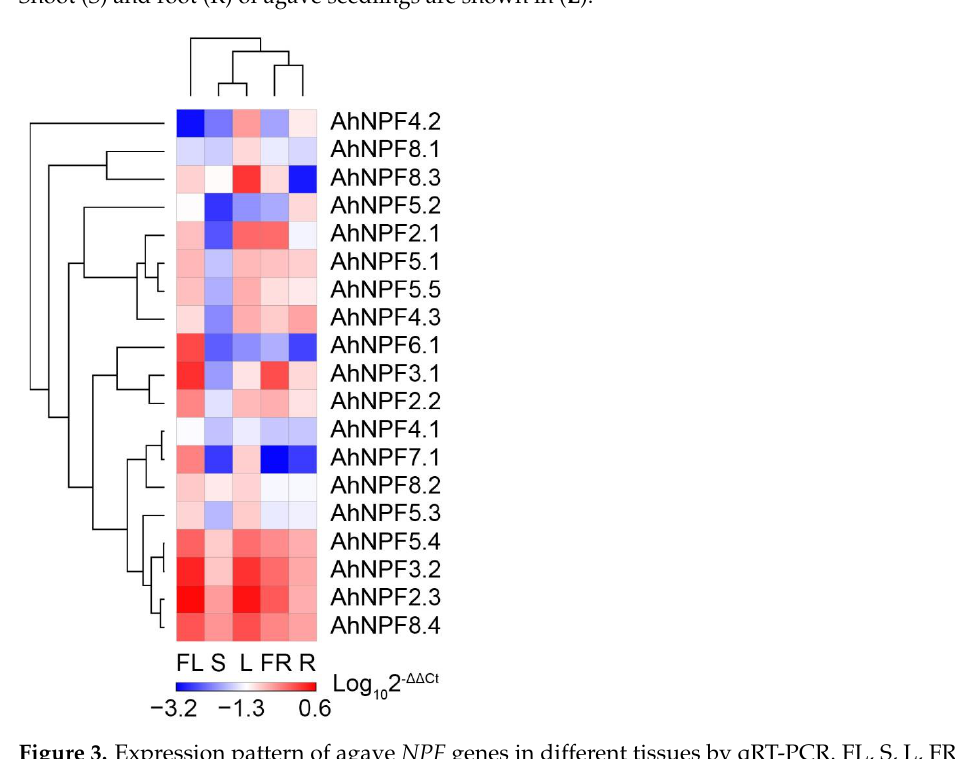
Figure 3. Expression pattern of agave NPF genes in different tissues by qRT-PCR. FL, S, L, FR and R represent flower, shoot, leaf, fruit and root, respectively. The genes and tissues were clustered by hierarchical clustering method [30].